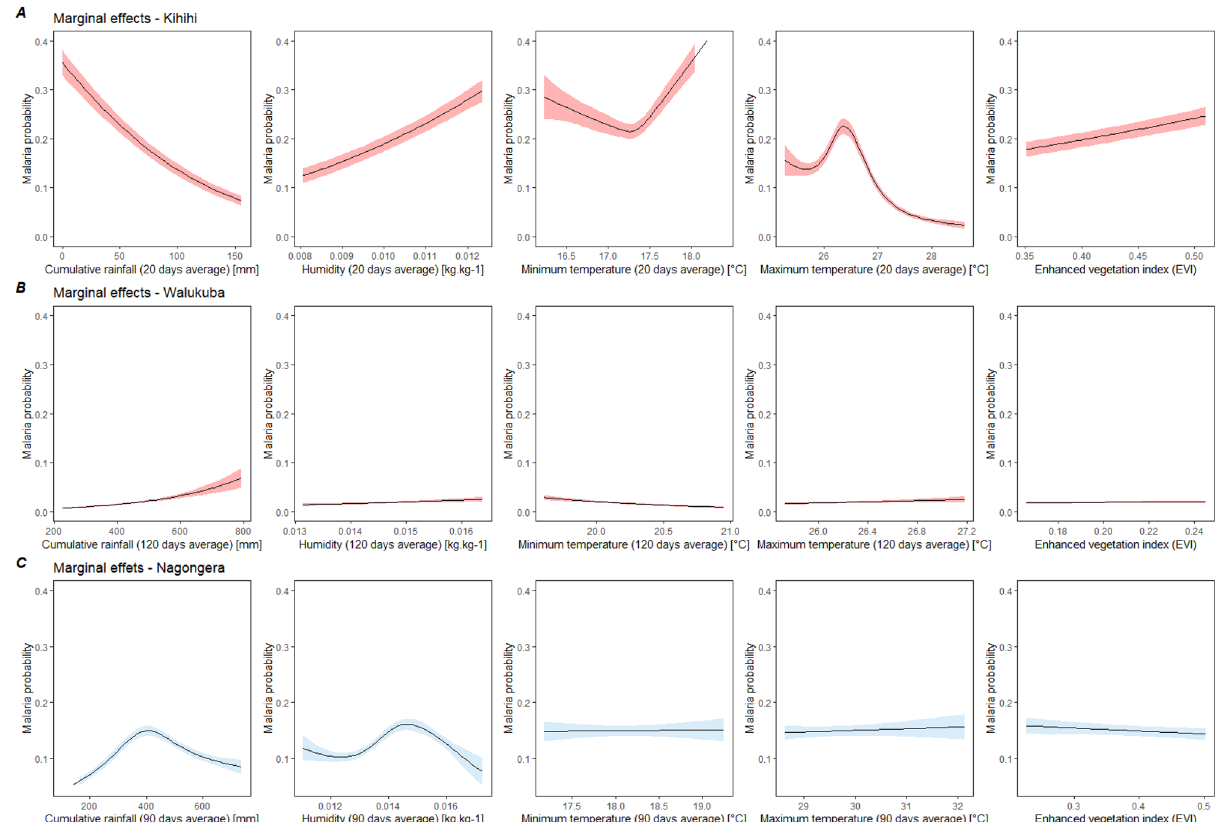
Figure 1. Marginal effects of environmental variables on malaria risk from GLMM models for each subcounty: Kihihi ( A ), Walukuba ( B ) and Nagongera ( C ). Models are adjusted for maximum and minimum temperatures, rainfall, humidity, EVI, age at visit, sex, housing type, household wealth index, number of persons living in the house, number of meat meal in all three models and Nagongera model is additionally adjusted for IRS. Models in red are not adjusted for intervention (IRS); models in blue are adjusted for